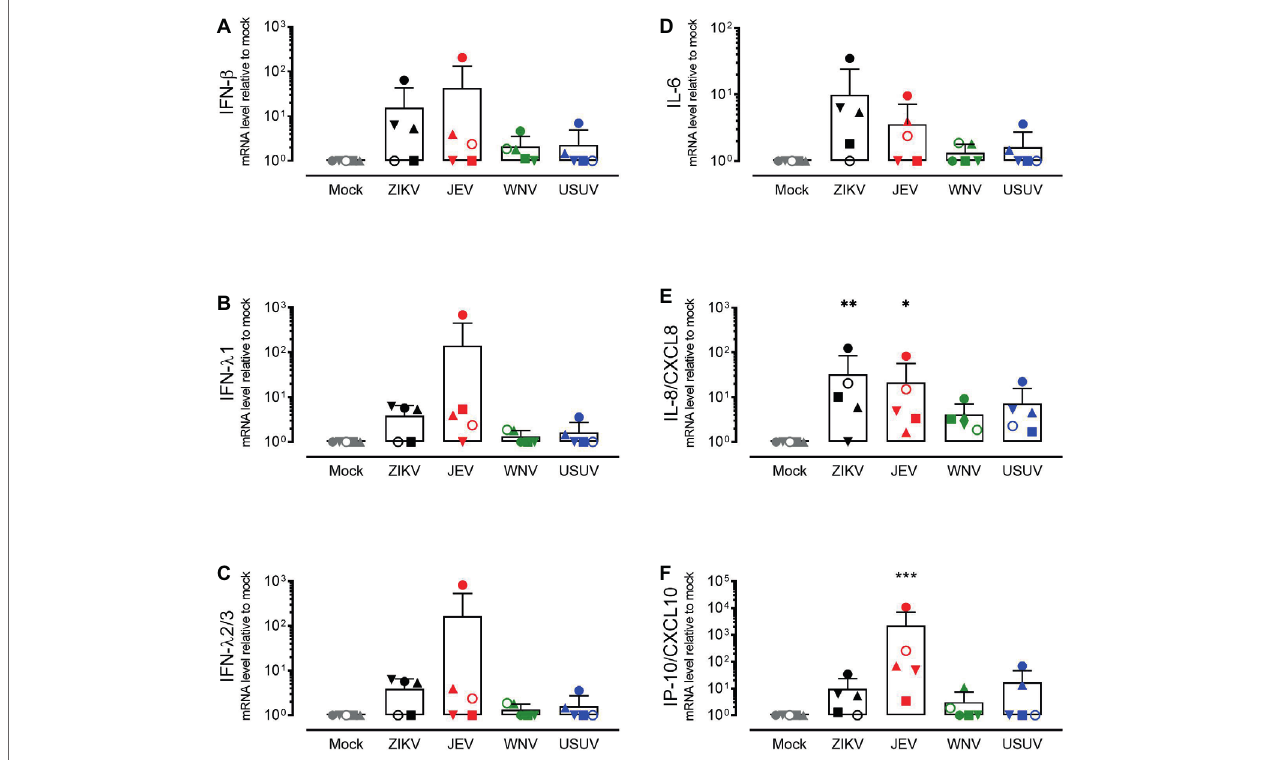
FIGURE 3 | Gene expression levels of antiviral mediators and pro-inflammatory cytokines by NECs after flavivirus infection. IFN- β (A) IFN- λ 1 (B) , IFN- λ 2/3 (C) , IL-6 (D) , IL-8/CXCL8 (E) , and IP-10/CXCL10 (F) mRNA levels measured by quantitative RT-PCR. Each symbol represents an independent donor (donor I: dot, donor II: square, donor III: upward triangle, donor IV: diamond, donor V: circle, and donor VI: downward triangle). Data are presented as mean and SD and stars indicate significance levels. * p < 0.05; ** p < 0.01; *** p <